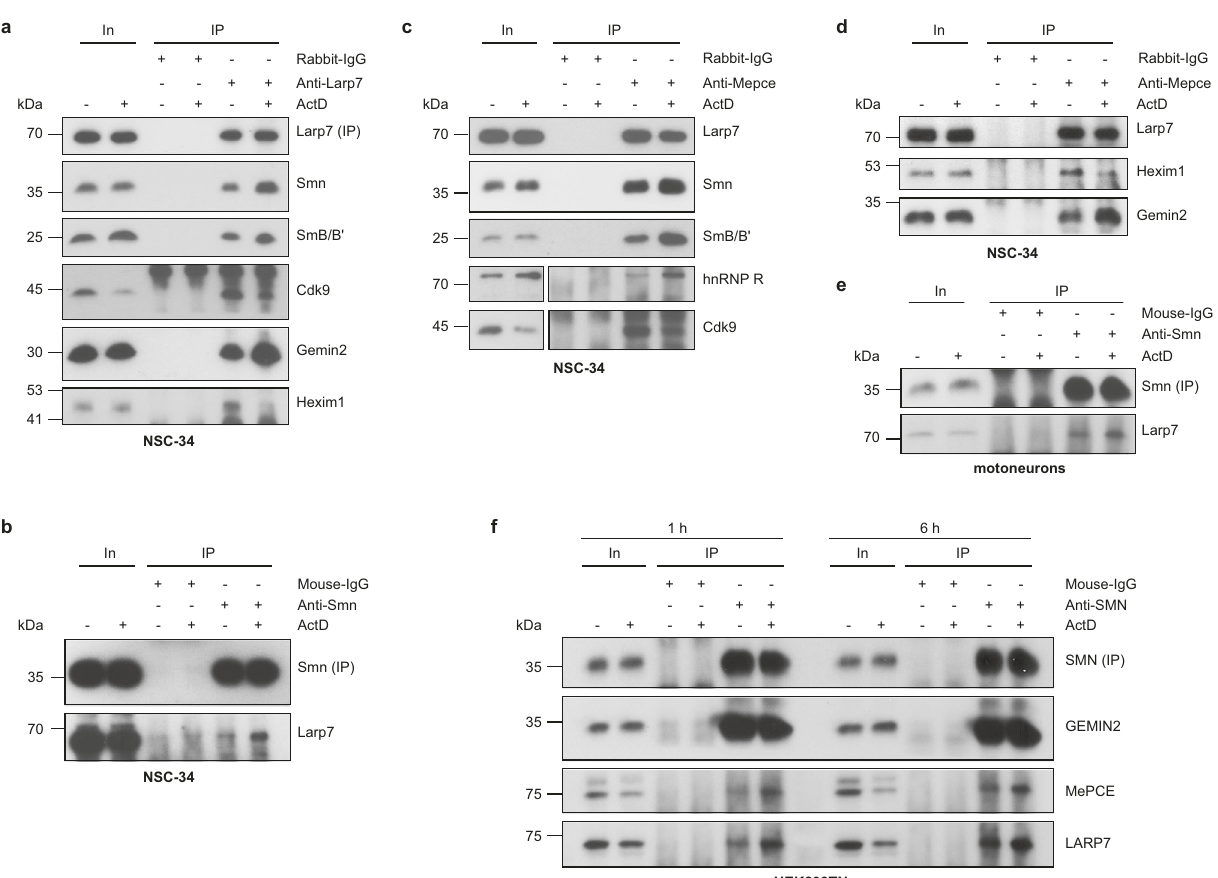
Fig. 2 Transcription-dependent regulation of 7SK/hnRNP/Smn complexes. a Western blot analysis of proteins co-immunoprecipitated by anti-Larp7 from NSC-34 cells treated with DMSO or actinomycin D (ActD) for 1 h. b Co-immunoprecipitation of Larp7 by anti-Smn from NSC-34 cells treated with DMSO or ActD for 1 h. c , d Co-immunoprecipitation of proteins by anti-Mepce from NSC-34 cells treated with DMSO or ActD for 1 h. For Western blots of hnRNP R and Cdk9, a shorter exposure of the inputs was chosen. e Co-immunoprecipitation of Larp7 by anti-Smn from cultured mouse primary motoneurons treated with DMSO or ActD for 6 h. f Co-immunoprecipitation of proteins by anti-SMN from HEK293TN cells treated with DMSO or ActD for 1 or 6 h. Source data are provided as a Source Data fi